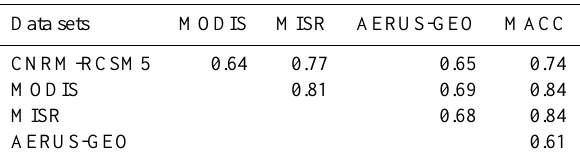
Figure 2. Mean aerosol optical depth at 550nm in summer 2012 (JJA) simulated by CNRM-RCSM5 and MACC (top) and measured by Fig. 2. Mean aerosol optical depth at 550 nm in summer 2012 (JJA) simulated by CNRM-RCSM5 and MACC (top), and measured by 3 three satellite instruments (MODIS, MISR and AERUS-GEO, bottom). satellite instruments (MODIS, MISR and AERUS-GEO, bottom) Table 2. Spatial correlation coefficients between AOD of the differ- ent data sets presented in Fig.